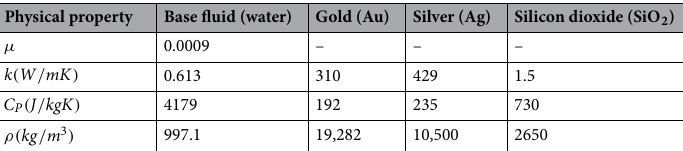
Table 1. Thermophysical properties of base fluid and